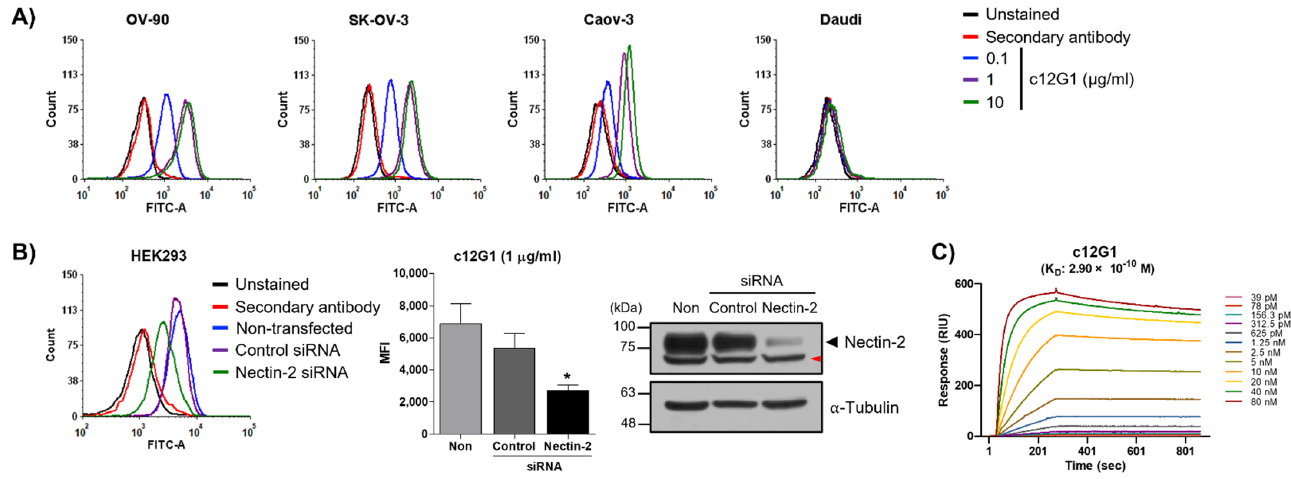
Figure 1. Characterization of the chimeric 12G1 (c12G1) antibody. ( A ) The binding of c12G1 antibody was determined using FACS analysis, at the indicated concentrations. Daudi cells were used as the nectin-2-negative cell line. ( B ) HEK293 cells were transfected with 40 nM of control or nectin-2 si-RNA, for 72 h. The FACS analysis was then conducted as described in the Methods section (*, vs. control si-RNA). Knock-down of nectin-2 expression was confirmed using western blot. Tubulin was used as the loading control. Anti-nectin-2 antibody from Abcam was used for western blot. The red arrowhead indicates a non-specific band. This experiment was independently repeated at least three times. ( C ) The binding affinity of c12G1 antibody to human nectin-2 was examined using SPR analysis. * p < 0.05.